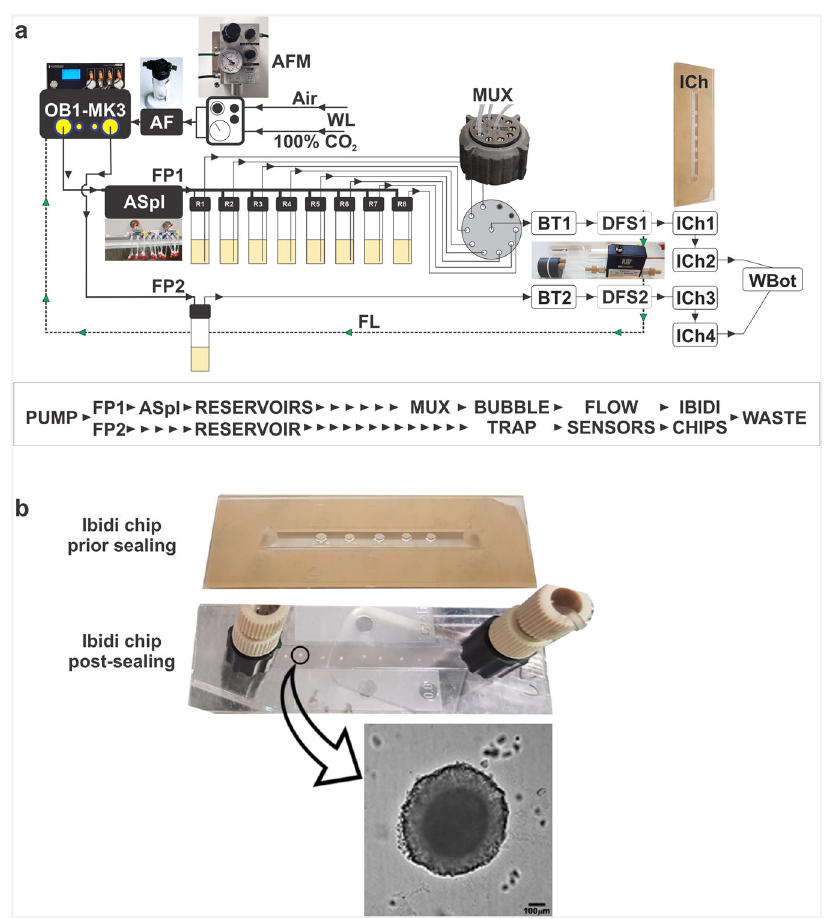
Fig. 1 Micro fl uidic platform design. a Components of the micro fl udic set up. Air and CO 2 from the wall lines (WL) are mixed in air fl ow mixer (AFM) and passed through air fi lter (AF) before reaching the pump (OB1-MK3). Flow path 1 (FP1) with air splitter (ASpl) shows eight outlets connected to the reservoirs with speci fi c drug concentrations. Time and fl ow rate of the reservoir content are regulated by the distributor (MUX) and piezo pump (OB1- MK3). The FP1 continues to a bubble trapper (BT) and a digital fl ow sensor (DFS) into 2 chained Ibidi chips (ICh 1,2) and fi naly to the waste bottle (WBot). Flow path 2 (FP2) for mock treated spheroids is represented by single reservoir and the two chained Ibidi chips (ICh 3,4). A feedback loop (FL) connects each digital sensor (DFS) to the OB1-MK3 pump to maintain desired fl ow rate. b Photograph of the Ibidi Luer chip with 8 Matrigel encapsulated